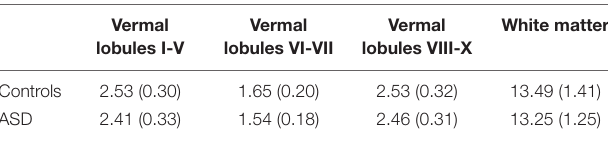
TABLE 3 | Volume of vermal and white matter